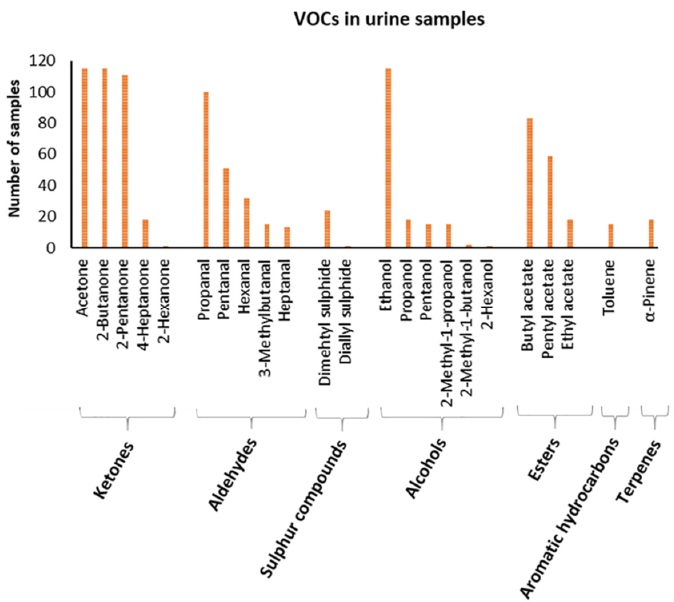
The molecules identified occur heterogeneously within the population (Figure 3).